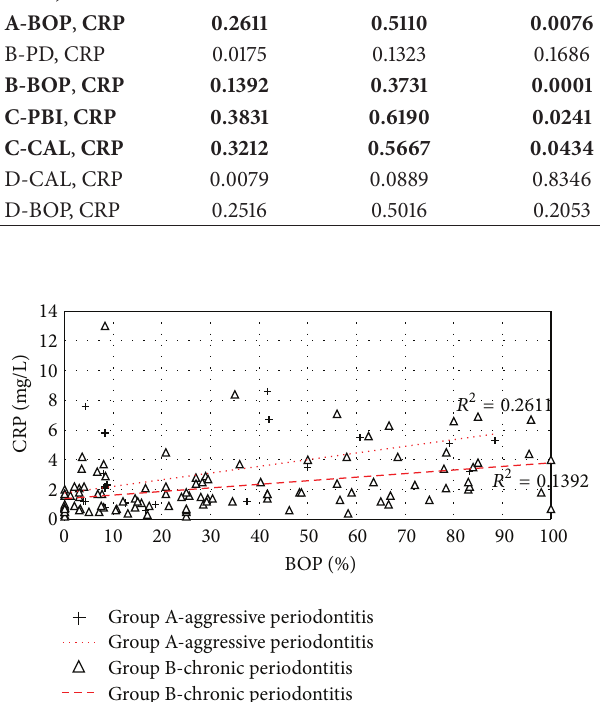
Figure 2: Statistical correlations between BOP and CRP levels in Group A and Group B ( 𝑅 2 : coefficient of determination).